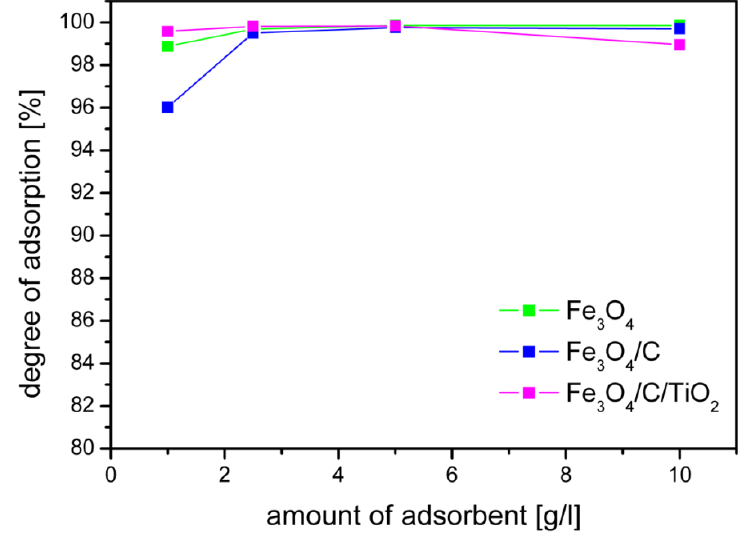
Figure 5. Influence of adsorbent dose on the degree of adsorption As(V) at equilibrium state, an initial concentration of arsenic ions 10 mg/L, and pH 2.